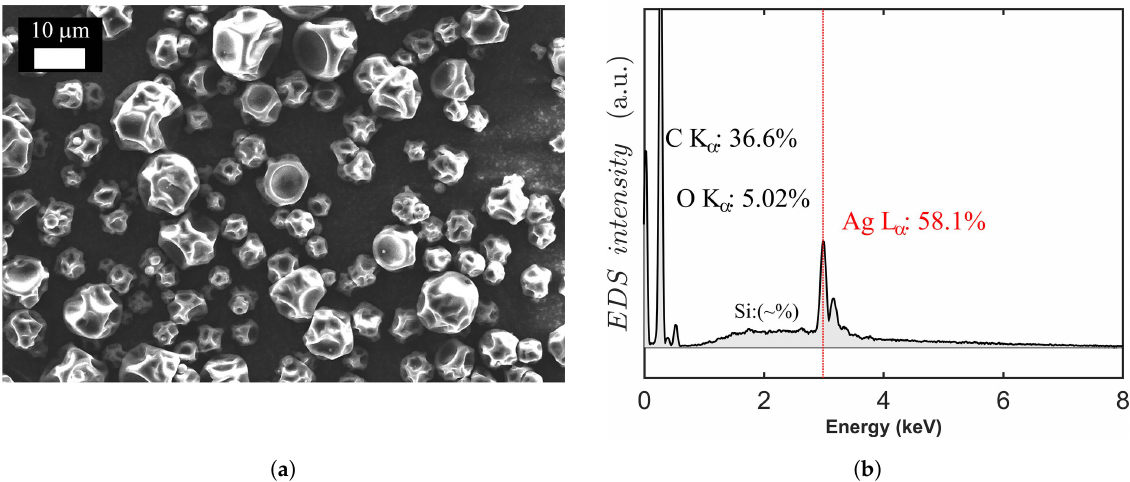
Figure 1. Antibacterial response of melt-spun polyfilmants against S. aureus in liquid (Ringer’s solution, 1/4 strength) after 24 h mixing at room temperature: Ag-containing PE and PLA samples with 1 w-% of additive concentration in both fibrous (polyfilament) and granulate form (prior to melt- spinning) are compared to polyamide-6 [6] control and reference samples (fPA, fPA10). The detection limit is 3 × 10 1 cfu/mL.